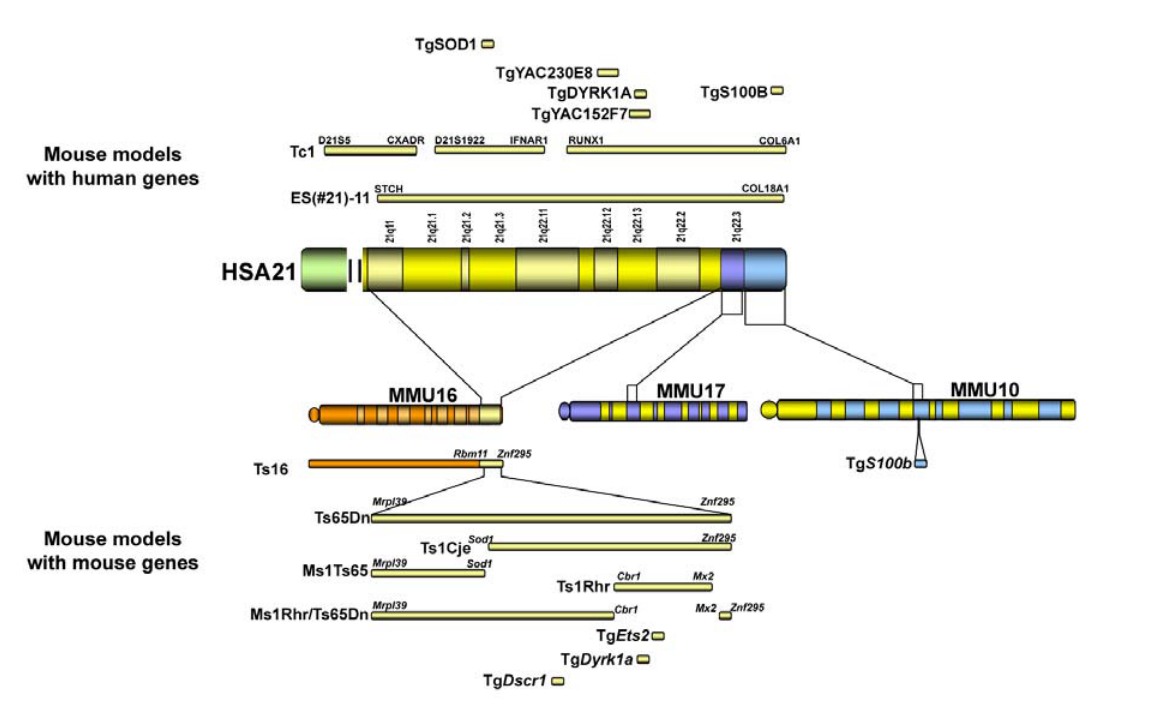
FIGURE 1. Mouse models of